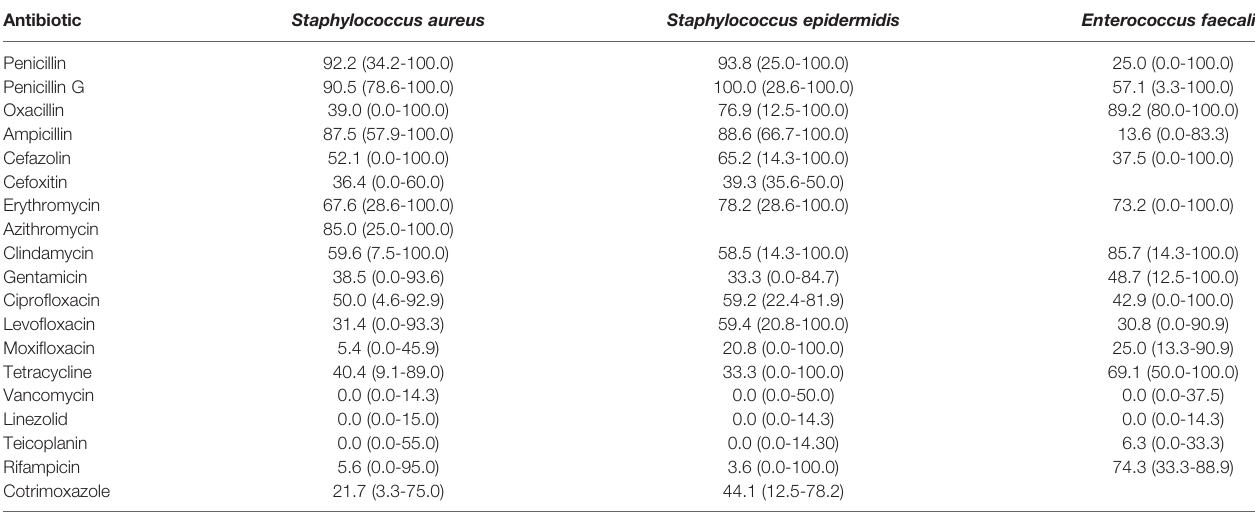
TABLE 2 | Antibiotic-resistant rate of common GP bacteria in the drug susceptibility tests (%).